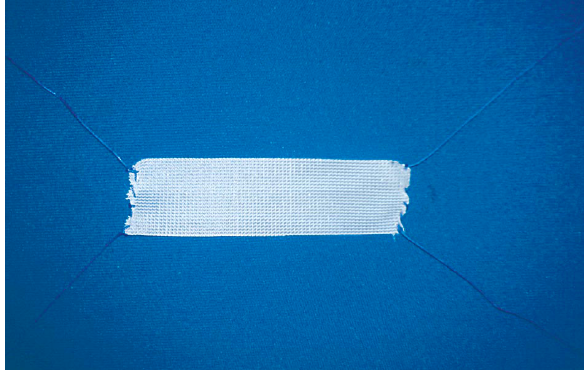
Figure 1 – Polypropylene mesh with poygalactyne-0 thread fixed to the extremities, confectioned by the